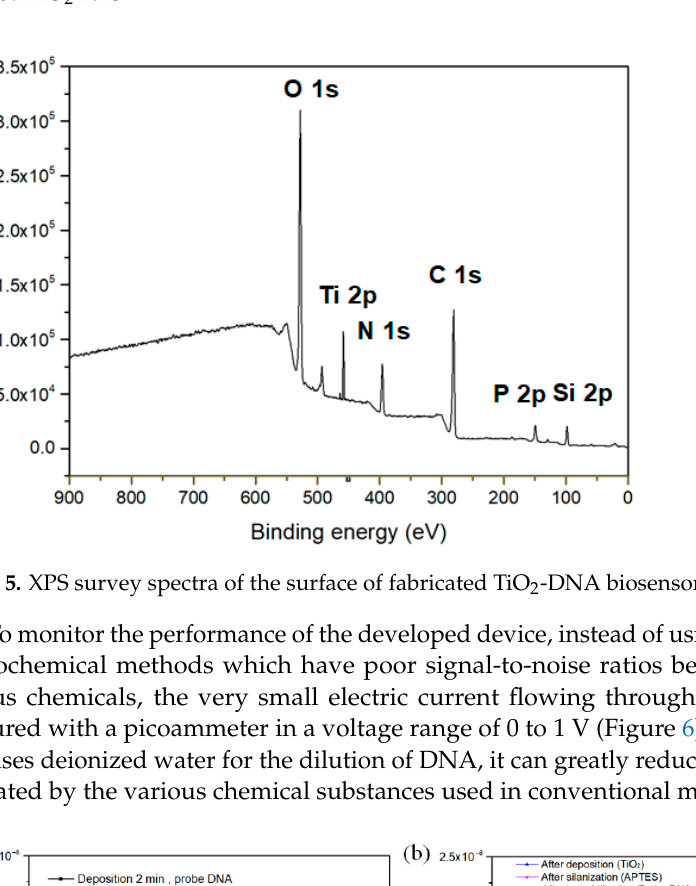
2 -DNA biosensor.